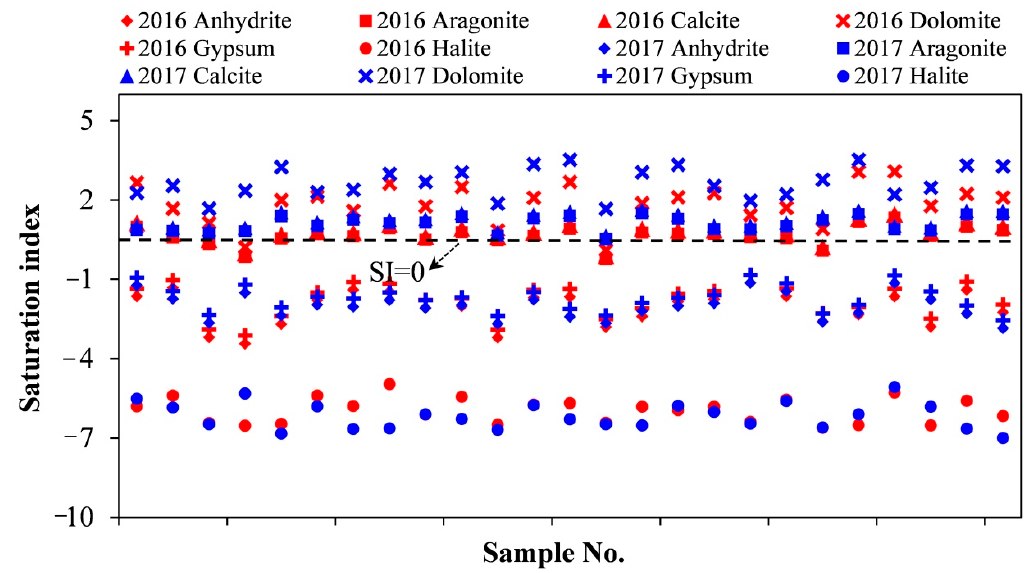
Figure 8. Saturation index (SI) for relevant minerals.